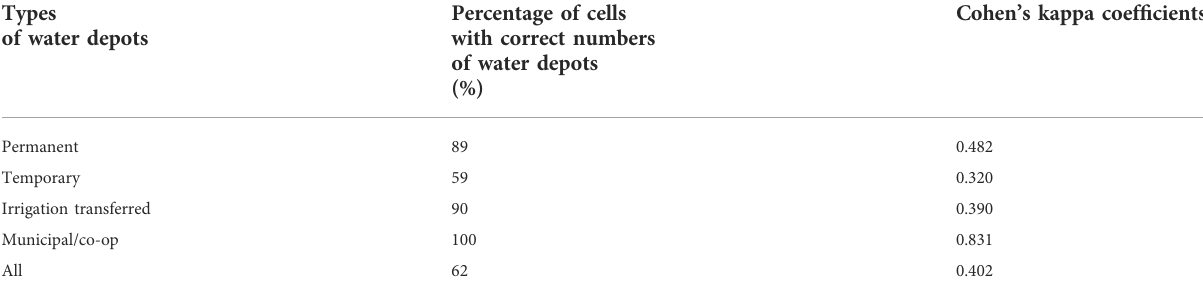
TABLE 4 Percentages of cells that were simulated with correct numbers of water depots and the Cohen ’ s Kappa coef fi cients for the four different types of water